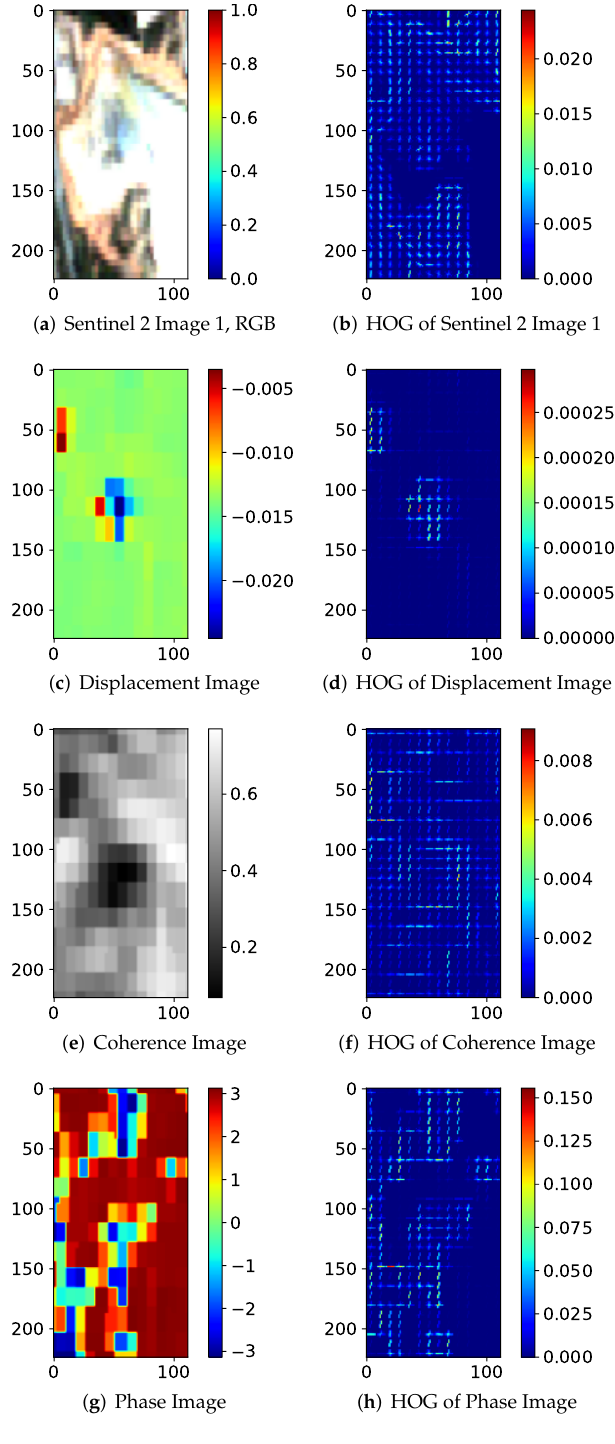
Figure 5. Histogram of Oriented Gradients of a positive blob in the dataset. The dataset was split into a training set of 80% and a completely held-out testing set of 20%. The held-out set was only used for reporting the generalization accuracy and other metrics. The 80% training set was used for both hyperparameter tuning and to replicate the experiment by training multiple models for a more robust estimate of model accuracy. For hyperparameter tuning, the parameters were obtained by using ten-fold cross- validation on the 80% training set. Ten-fold cross-validation was also employed to replicate the experiment to report expected accuracy and variance. For replication, we used